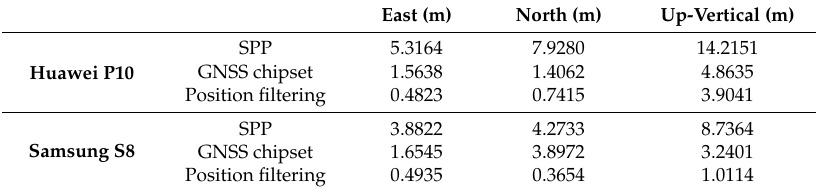
Table 1. The statistics of root mean square (RMS) errors of different positioning methods, including GNSS processed by single-point positioning (SPP), and results of the GNSS chipset built-in smartphones and GNSS processed by our proposed method (positioning